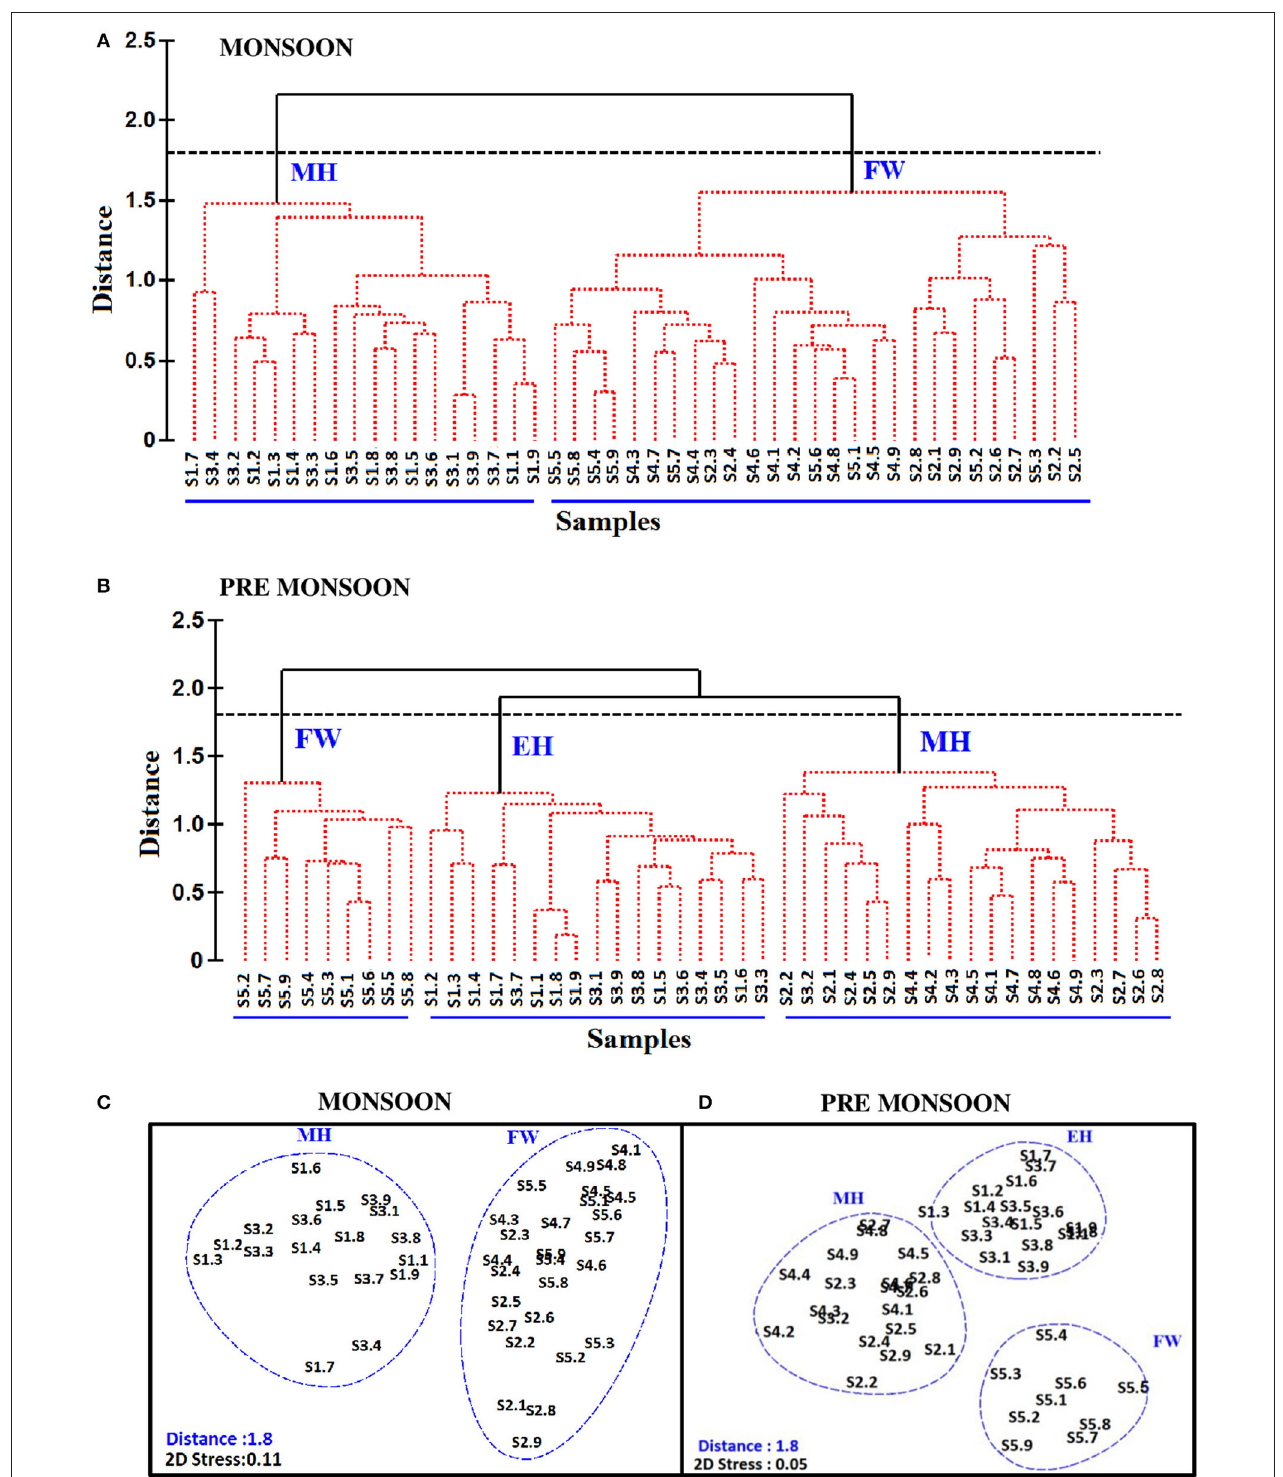
FIGURE 5 | Cluster plot representing the segregation of stations based on the distribution of physico-chemical and biological parameters during (A) monsoon (MON) and (B) pre-monsoon (PRM). The stations are represented from S1 to S5. Numbers 1-9 represent the nine time series observations carried out at each sampling station (i.e: S1.1, S1.2,...to S1.9 represent time series observations at station S1). Non metric multidimensional scaling (NMDS) is shown in panels (C,D) , which represent the distribution of time point observations at different stations using salinity and biological parameters during MON and PRM, respectively. The clusters are named as euryhaline (EH), mesohaline (MH) and freshwater (FW), based on the salinity values.